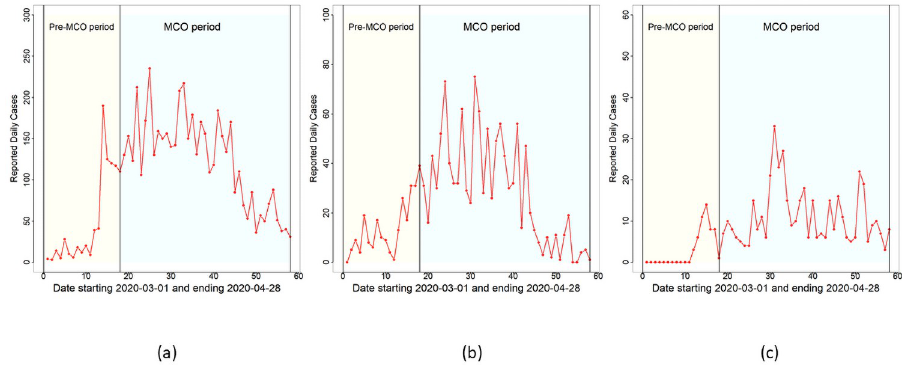
Fig 1. Reported daily cases. Reported daily cases for (a) Malaysia, (b) Selangor and (c) Sarawak. The time period considered is from March 1, 2020 to April 28, 2020.